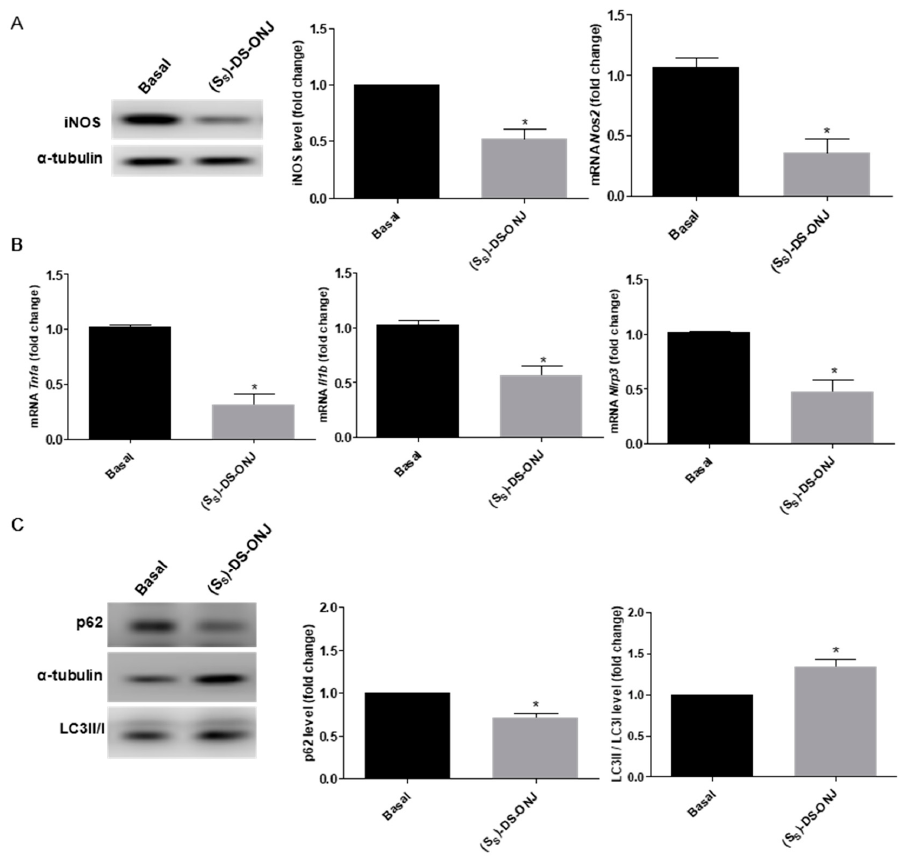
Figure 7. ( S S )-DS-ONJ ameliorates inflammatory parameters in AK explants from pre-diabetic BB rats. ( A ) Analysis of iNOS in AK explants from BB rats during DN progression. Protein levels were analyzed in AK explants by Western blot. α -tubulin was used as a loading control (n = 6 AK explants per condition). mRNA levels of Nos2 were determined by qRT-PCR and Actinb was used as housekeeping control (n = 6 AK explants per condition). ( B ) mRNA levels of Tnfa , Il1b and Nlrp3 were determined by qRT-PCR and Actinb was used as housekeeping control (n = 6 AK explants per condition). ( C ) Protein extracts were analyzed by Western blot with antibodies against LC3II/I, p62 and α -tubulin as loading control of p62 (n = 6 AK explants per condition). The fold change relative to the basal condition is shown; * p ≤ 0.05 vs. Basal condition (Mann-Whitney